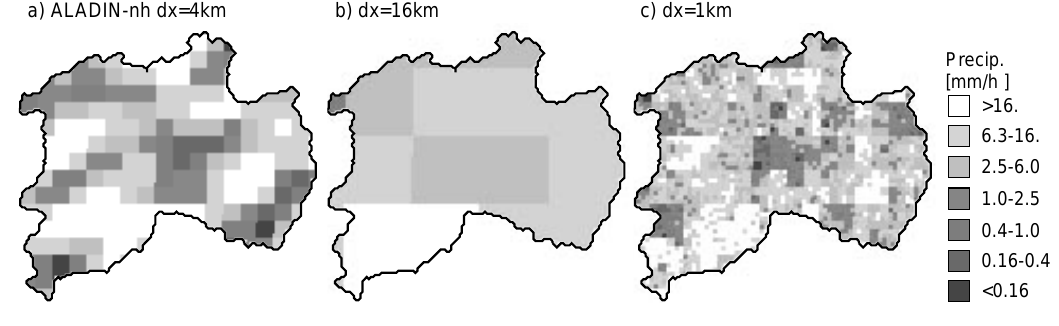
Fig. 7. Same as Fig. 6, but for ALADIN-nh products with (a) the original grid with 4km, (b) a coarse grid with 16km and (c) a fine grid with 1km grid